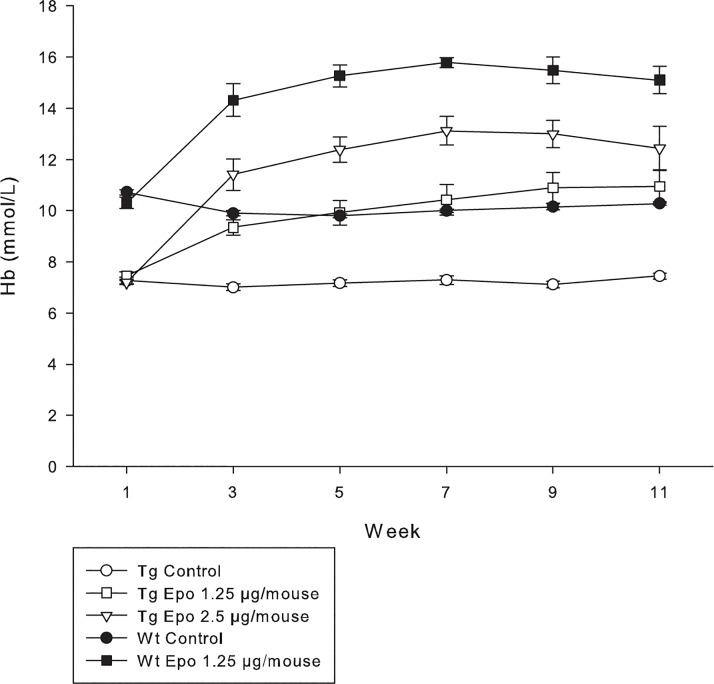
Haemoglobin measurements.Haemoglobin (Hb) is measured in the blood from the mice. Tg mice (open symbols) are anaemic compared to Wt mice (solid symbols), but the haemoglobin levels are restored in Tg mice 2 weeks after injection.